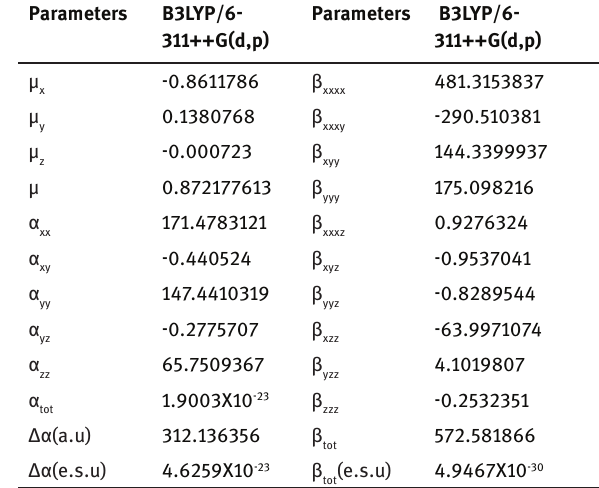
Table 3 : NLO properties of N